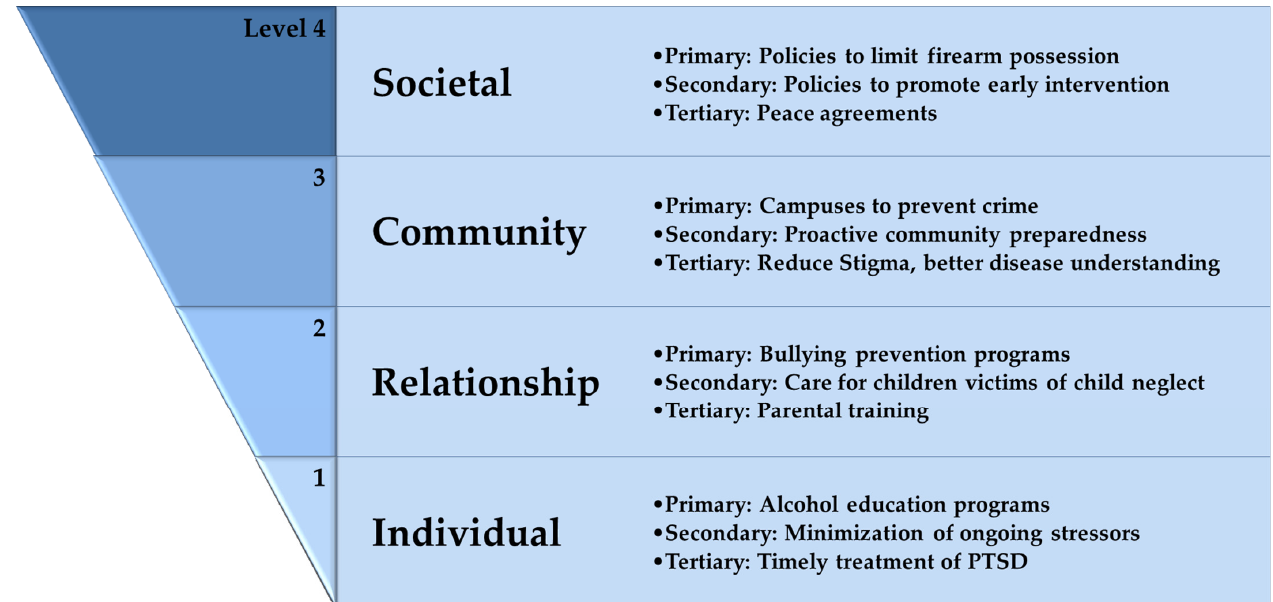
Figure 2. The social-ecological model of disease prevention as applied to PTSD. For each of the four levels, examples of primary, secondary, and tertiary prevention are given.